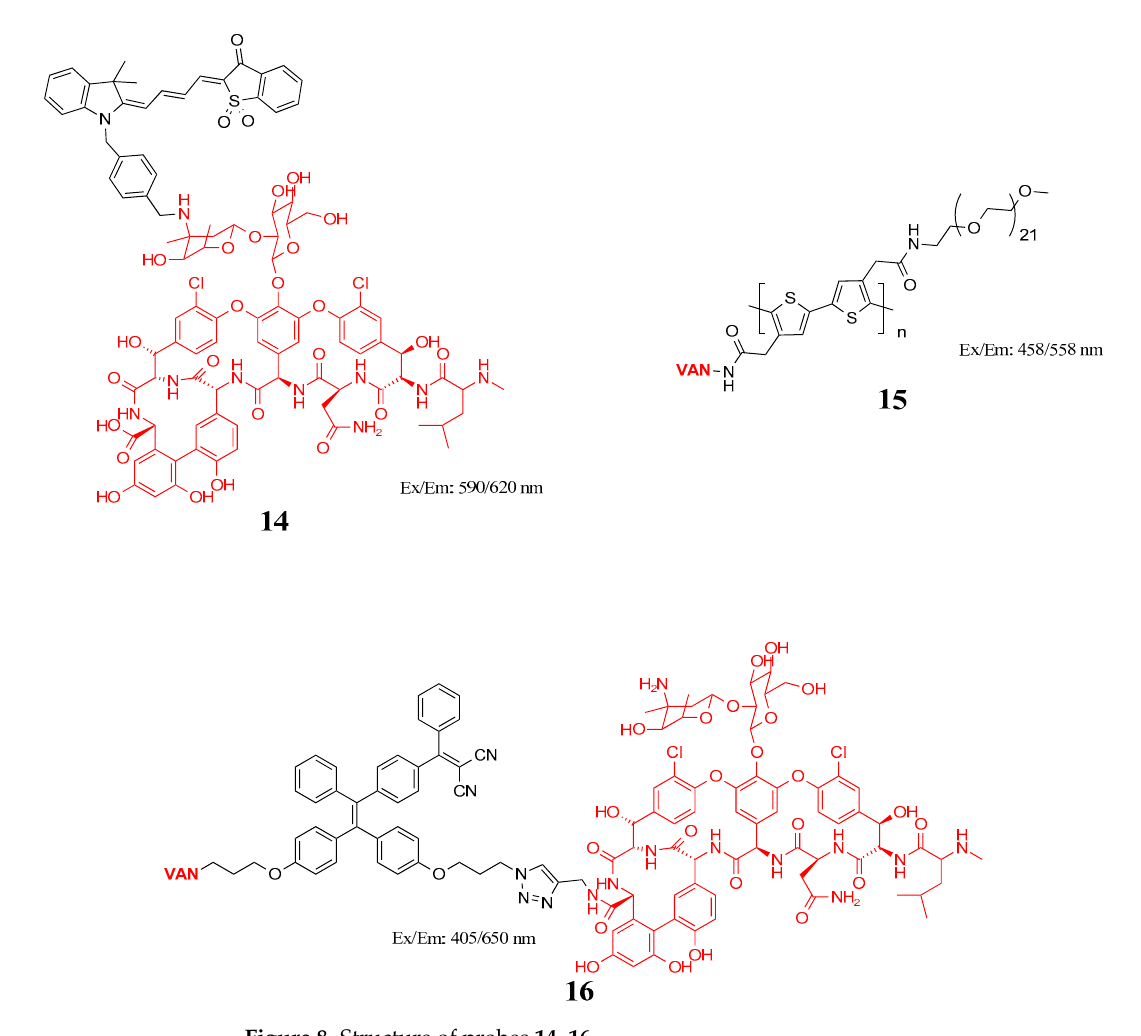
Figure 8. Structure of probes 14 – 16